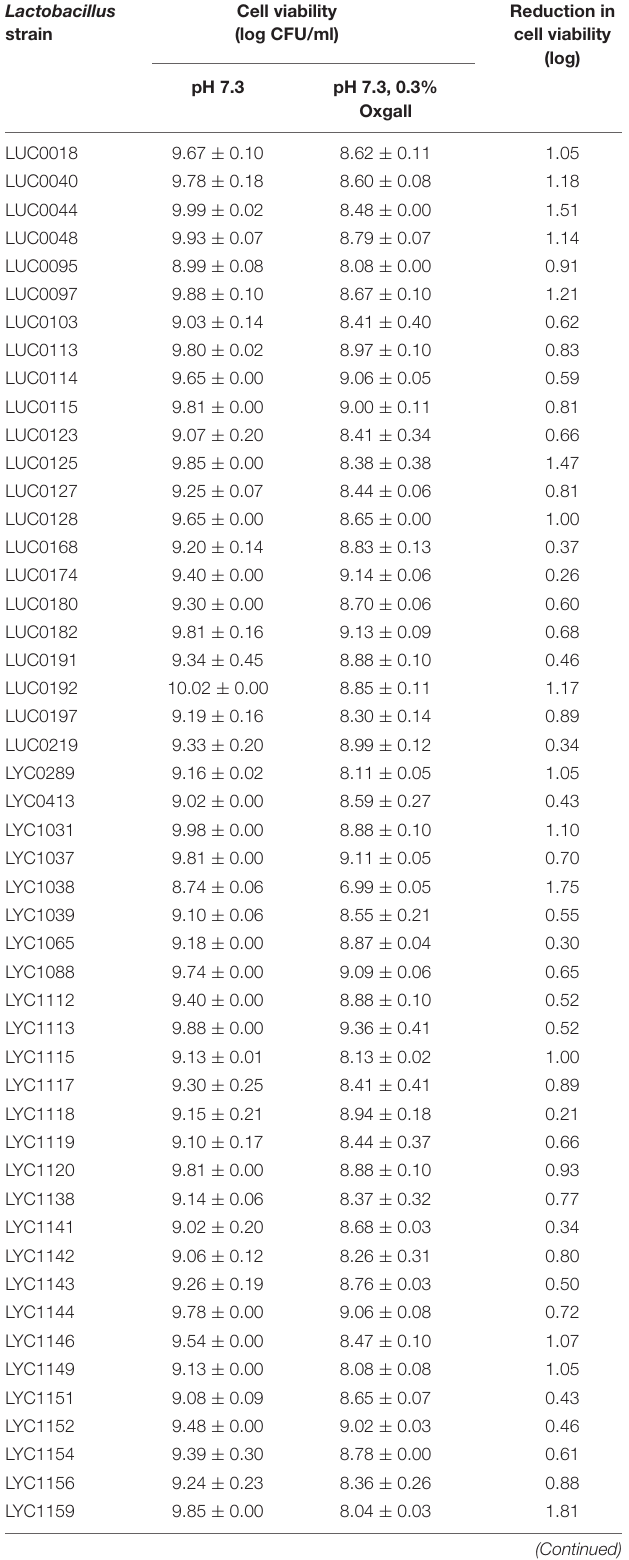
Cell viability (log